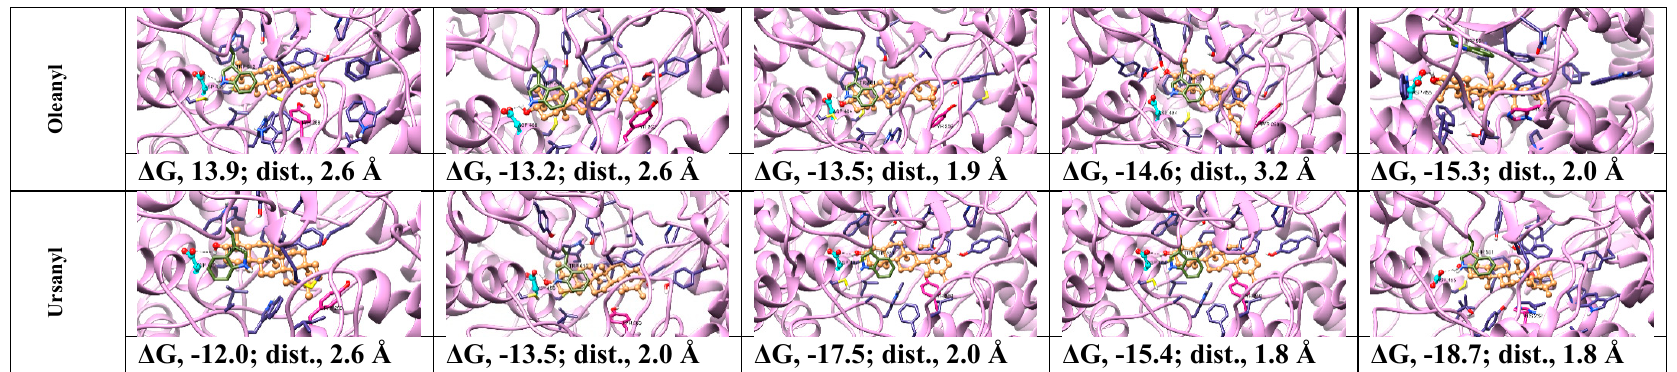
Figure 8. Poses, ligand to protein distances and affinities of oxidosqualene cyclases (OSCs) docked with the intermediate cations from fruit models and human x ‐ ray structure. Δ G, Gibbs free ‐ energy of binding (kcal mol − 1 ); dist, ligand ‐ OH.…OOC ‐ Asp ‐ protein distances, ligand, brown; catalytic Asp, cyan; Trp docking reference, green; Tyr/His: magenta. Residues surrounding the active site, dark blue; oxygen atoms, red; nitrogen atoms, light blue and hydrogens, white.